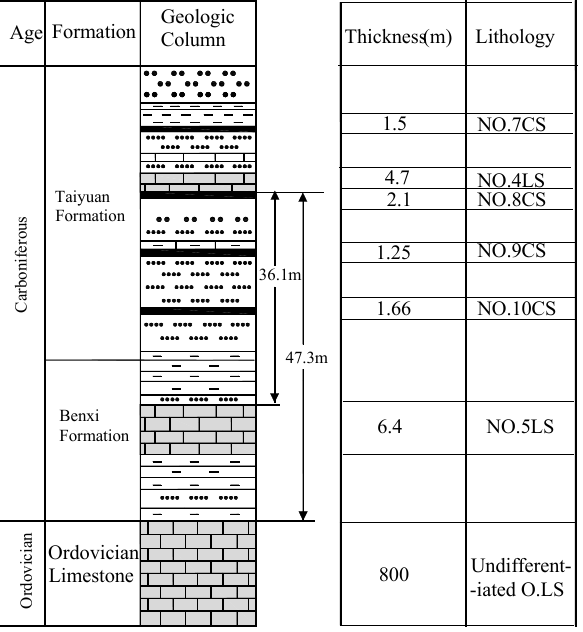
Figure 2. Stratigraphic section for the 8826 working face (CS = Coal Seam, LS =